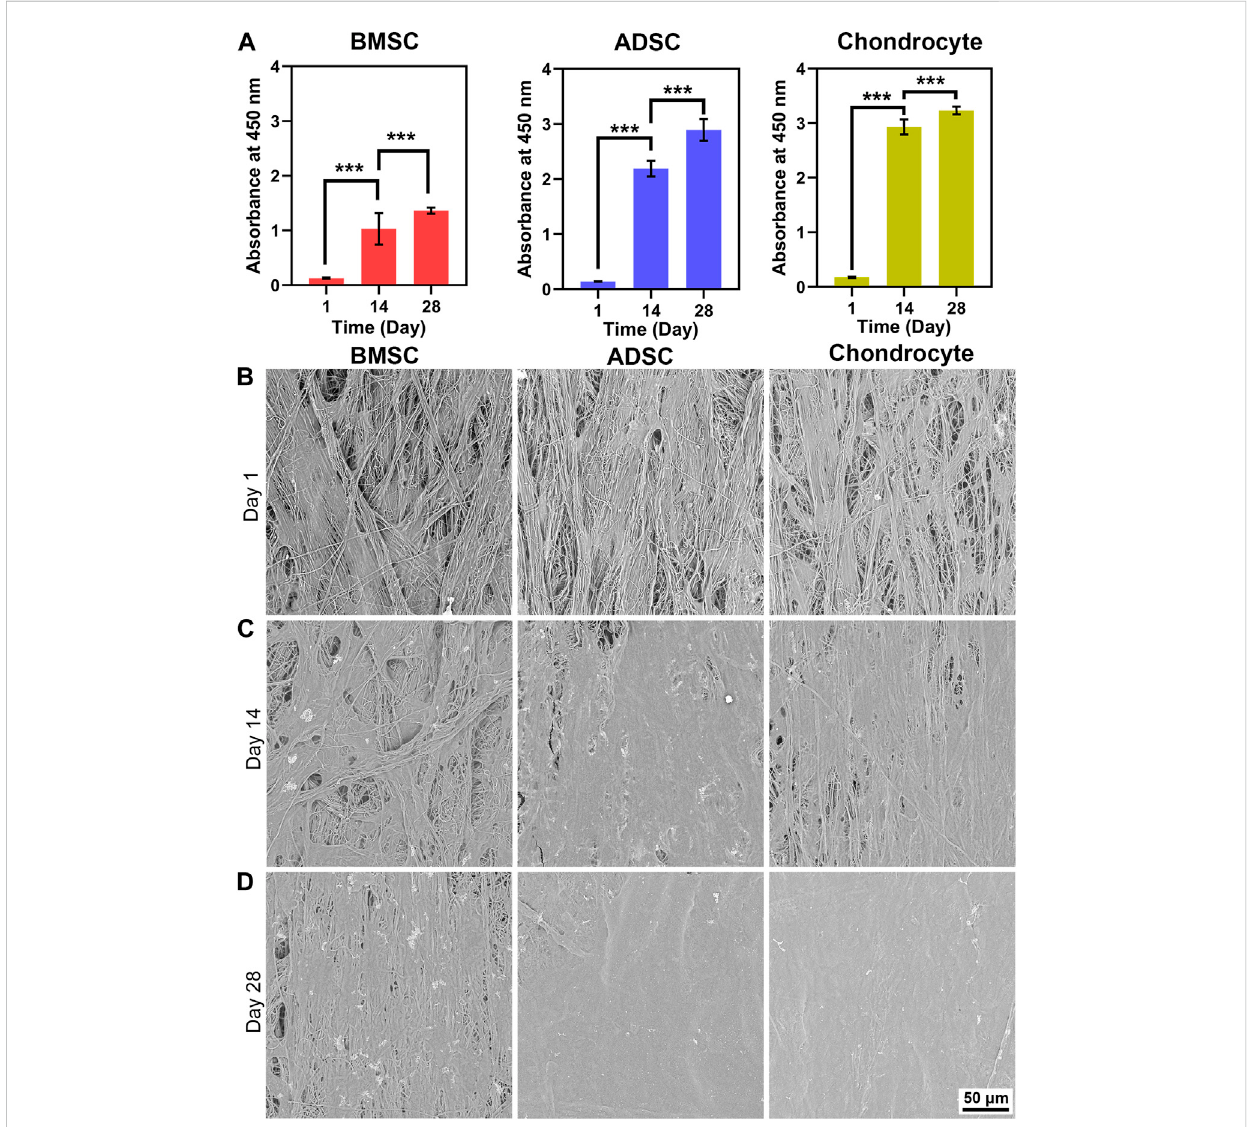
FIGURE 2 Cell proliferation and morphology on electrospun yarn scaffolds. CCK-8 assay reveals that cells proliferate robustly (A) , which is con fi rmed by increased cell coverage on scaffolds from day 1 – 28 (B – D) . *** p <